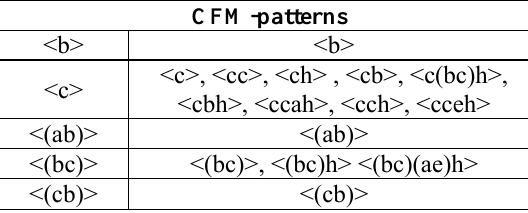
Table 4. Final progressive